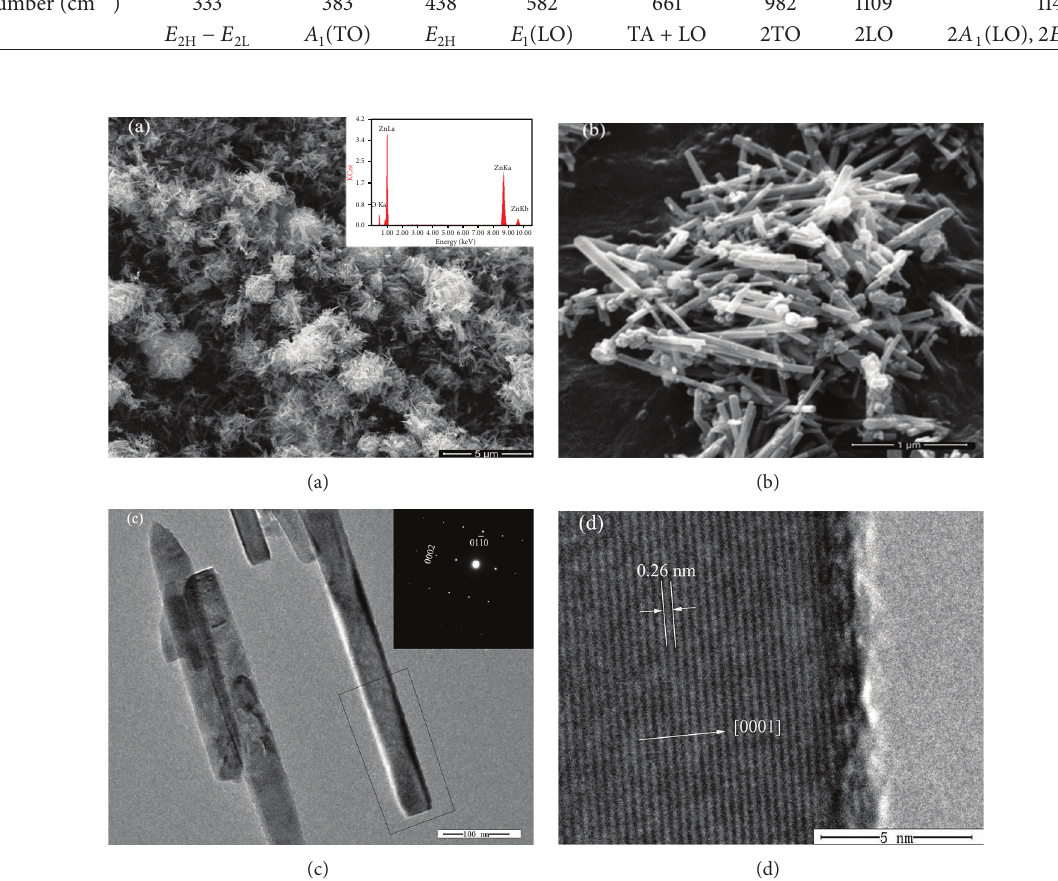
Figure 3: (a) Low magnification SEM image of the as-prepared ZnO nanorods with the corresponding EDS (inset). (b) A representative SEM image of the ZnO nanorods. (c) A representative TEM image of the ZnO nanorods with the corresponding SAED pattern (inset). (d) HRTEM image showing the difference between two lattice fringes, which is about